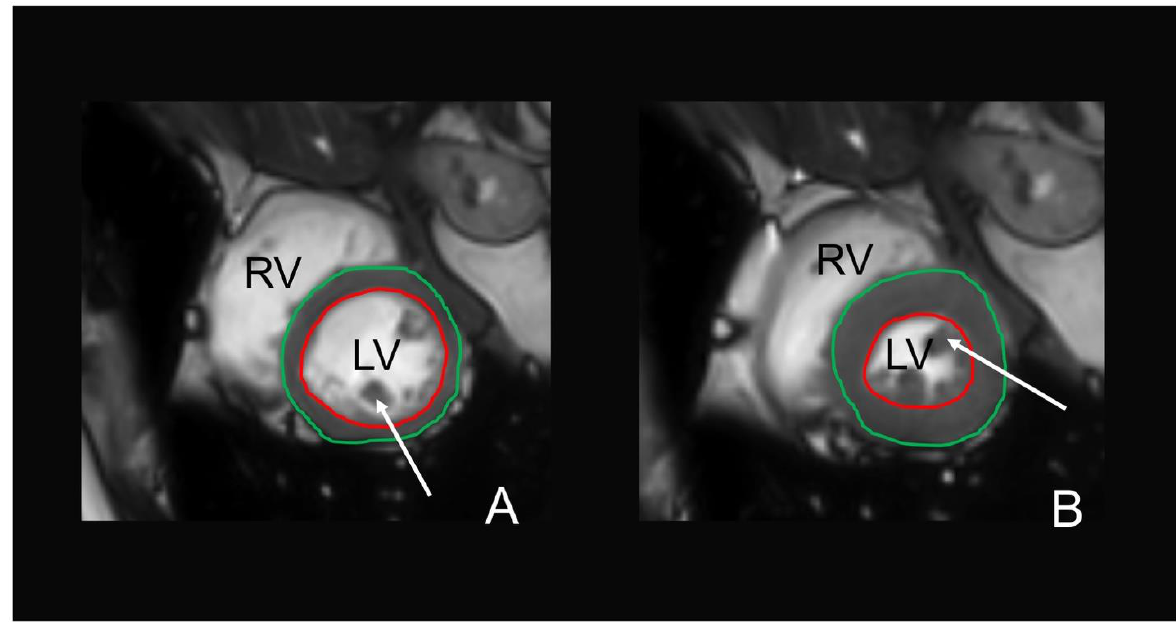
Figure 2. MRI-based assessment of the left ventricular function on cine steady-state free precession (cine-SSFP) sequences in a 56-years-old female. The endocardial (red contour) and epicardial (green contour) border were detected automatically in end-diastole ( A ) and end-systole ( B ) and manually corrected, if necessary. The papillary muscles (white arrows) were included in the left ventricular lumen. LV = left ventricle, RV = right ventricle.